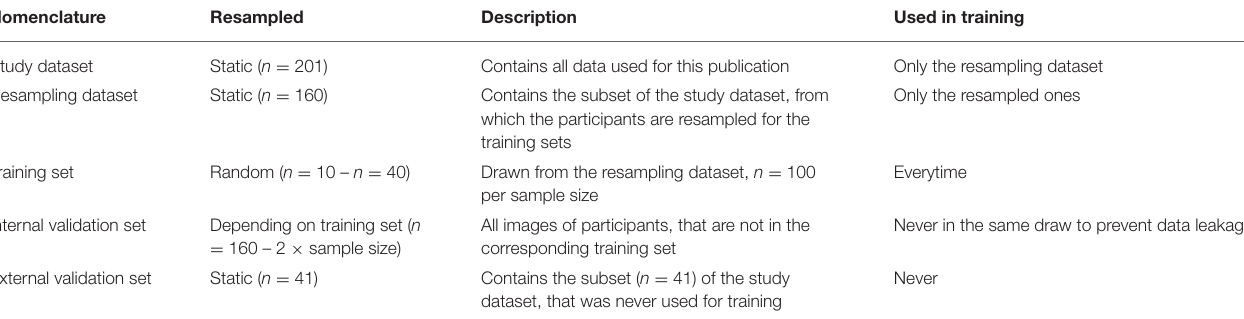
TABLE 1 | Description of datasets.